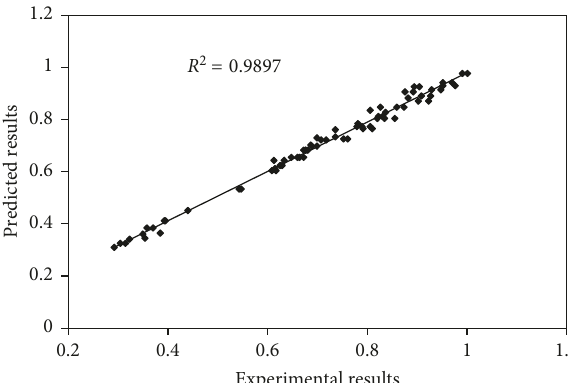
Figure 14: Linear relationship between measured and predicted compressive strengths for the Polak–Ribiere conjugate gradient backpropagation algorithm of ANN.